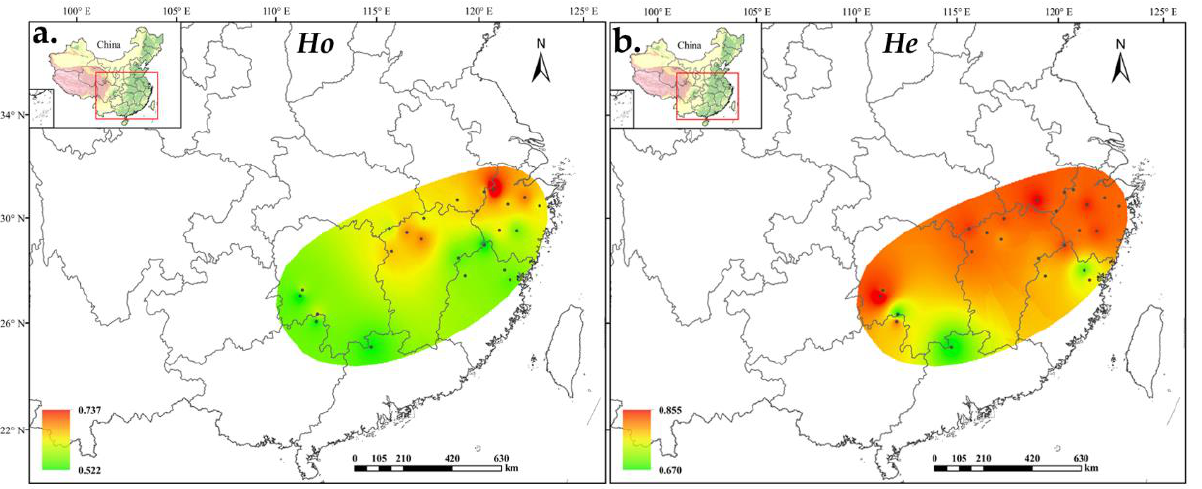
Figure 1. Distribution of A. chinensis population diversity based on ( a ) observed heterozygosity and ( b ) expected heterozygosity.